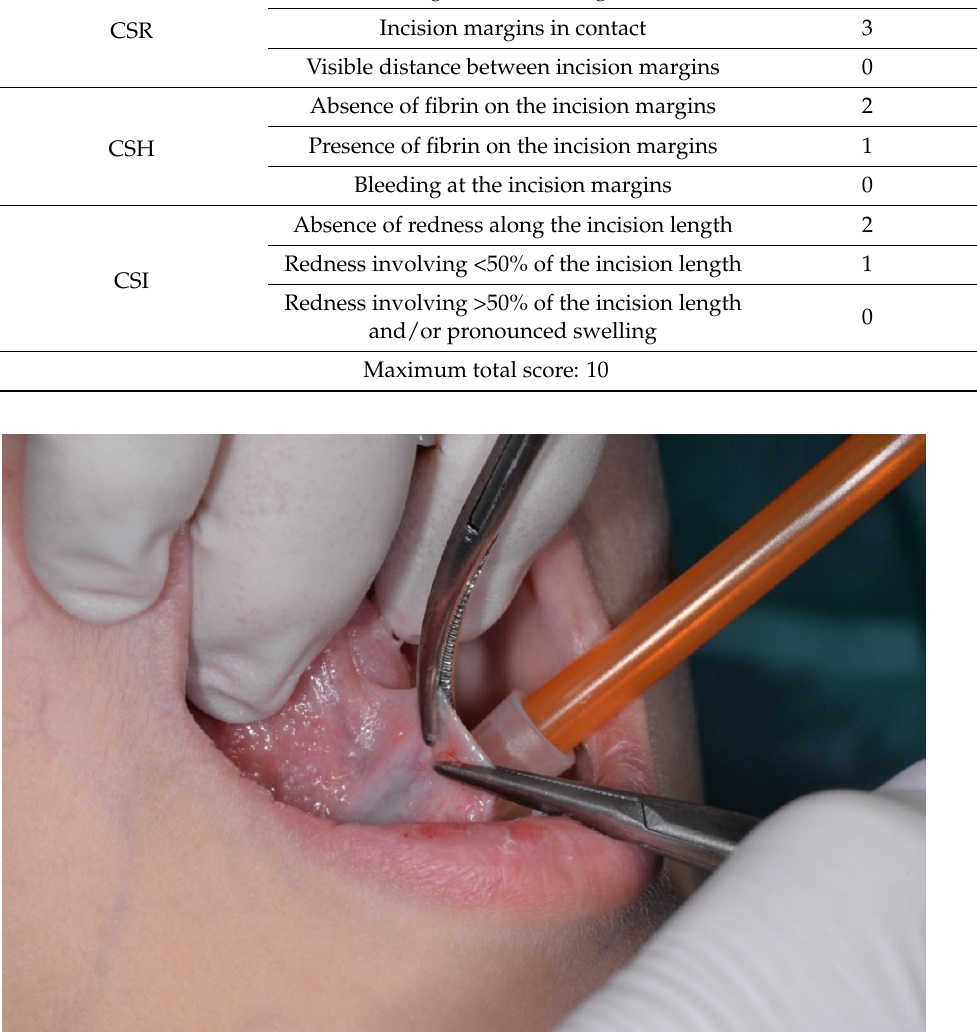
Figure 1. Clamping of the frenulum using two hemostatic forceps.